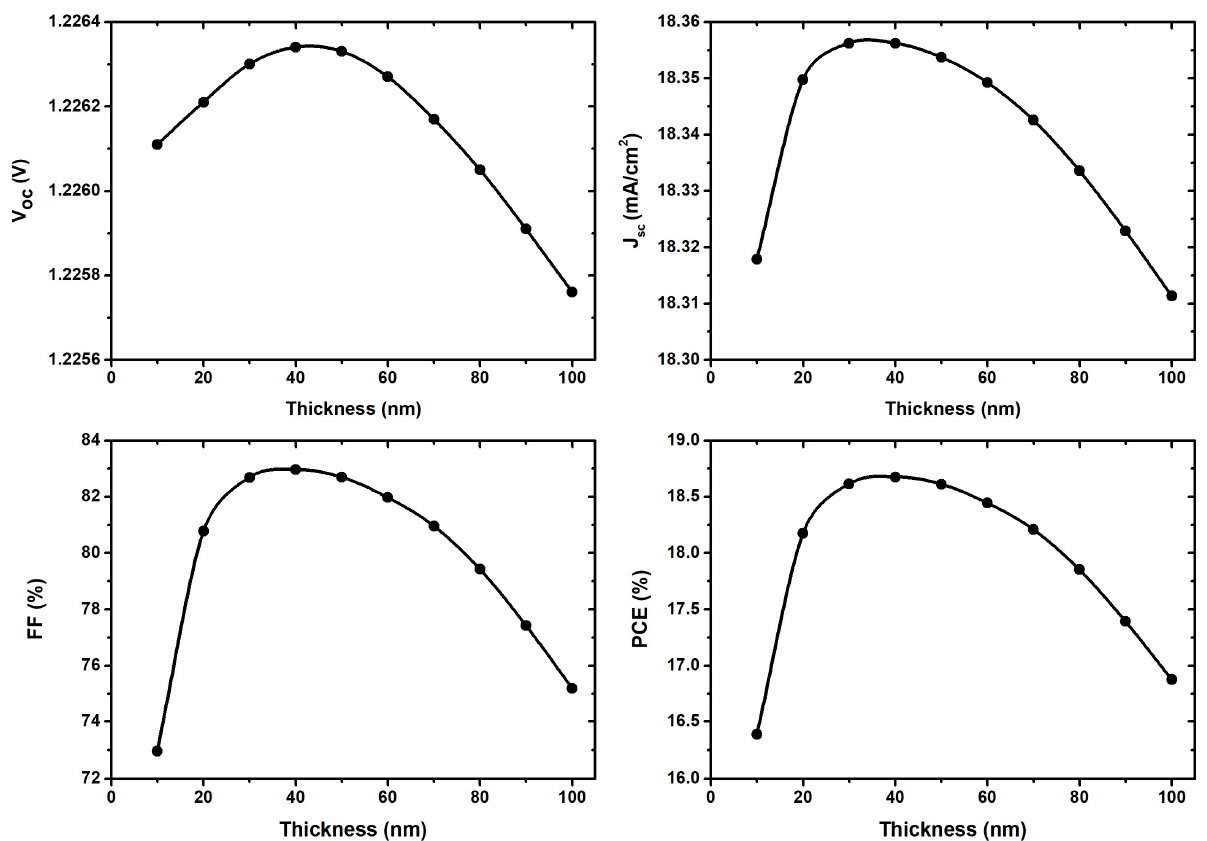
Figure 9 . Solar cell performance parameters with varying ZMO thickness. Figure 9. Solar cell performance parameters with varying ZMO